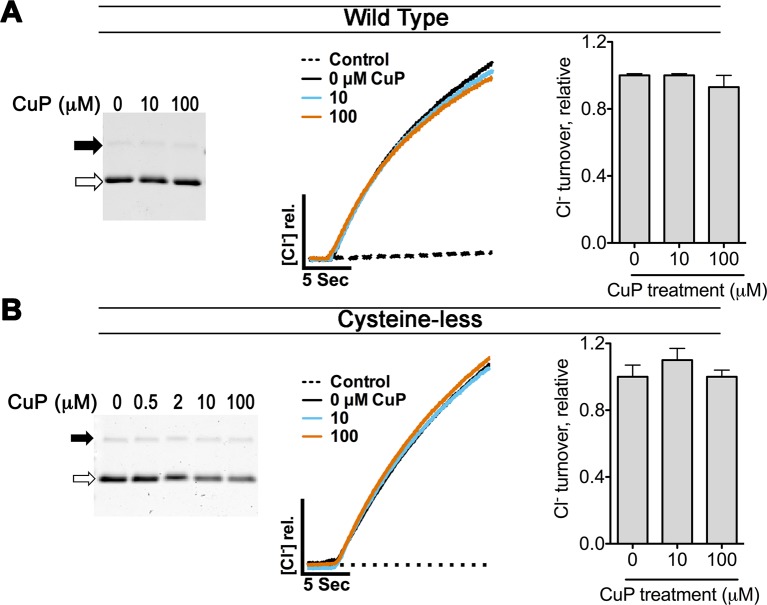
Control experiments on WT and cysteine-less ClC-ec1.The WT ClC-ec1 background was used for Y419C and N-deletion (crystallization construct) mutants; the cysteine-less ClC-ec1 background was used with all other constructs in this study. (A) Control experiments on WT ClC-ec1. Left: SDS-PAGE analysis of CuP-treated WT ClC-ec1. Arrows indicate migration position for the cross-linked dimer (solid) or uncross-linked monomer (open). The presence of a prominent monomer band indicates that CuP does not cross-link this template. Middle: Representative traces of Cl--efflux mediated by WT or cysteine-less ClC-ec1. Right: Relative Cl- transport rates for WT and cysteine-less ClC-ec1 (mean ± SEM, n=3–4). (B) Control experiments on cysteine-less ClC-ec1. Panels as in (A).